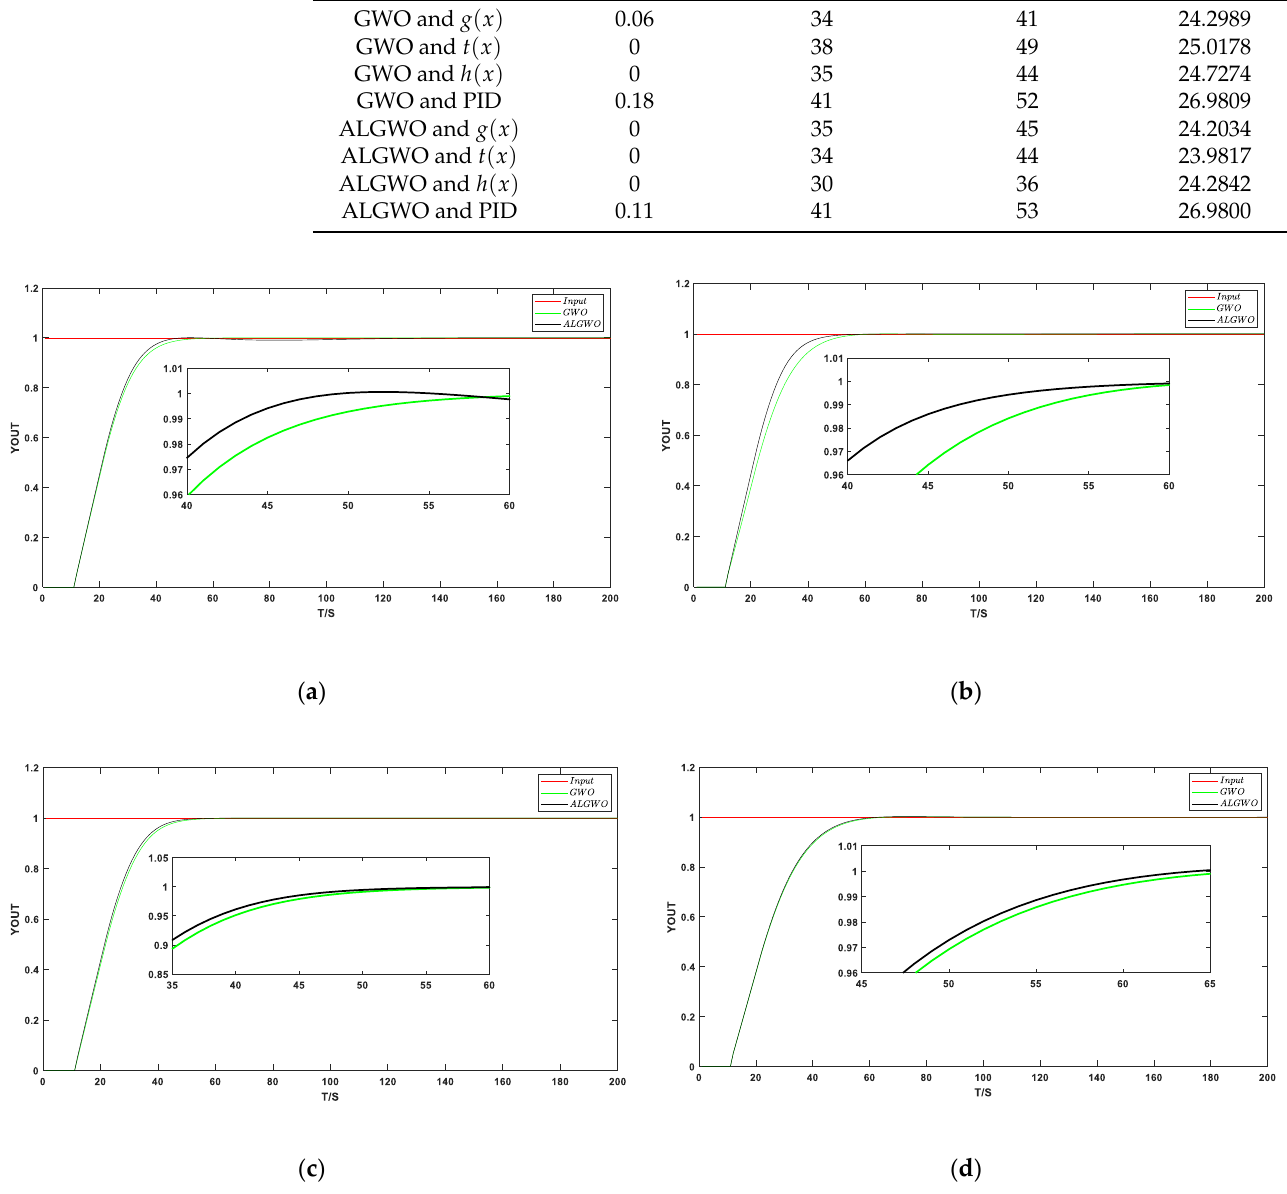
Figure 12. The step response results on test system 5. ( a ) The simulation results of BPNN-PID using